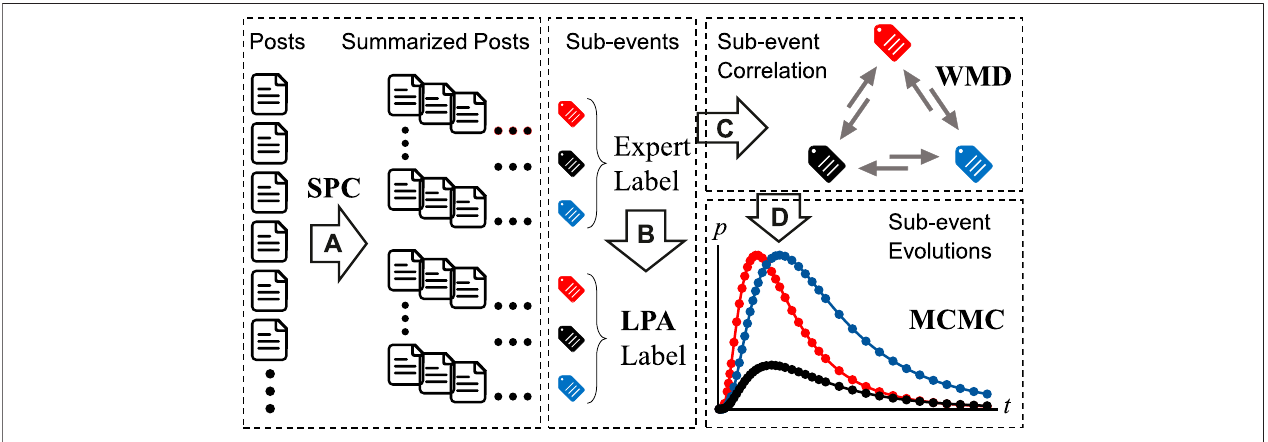
FIGURE1| (Coloronline)Schematicillustrationoftheproposedmethod. (A) PostsummaryisconductedbySinglePassClustering(SPC). (B) Sub-eventlabelingis executedbytheLabelPropagationAlgorithm(LPA). (C) Sub-eventcorrelationiscarriedoutbyWordMover ’ sDistance(WMD). (D) Sub-eventevolutionisregeneratedby Markov Chain Monte Carlo